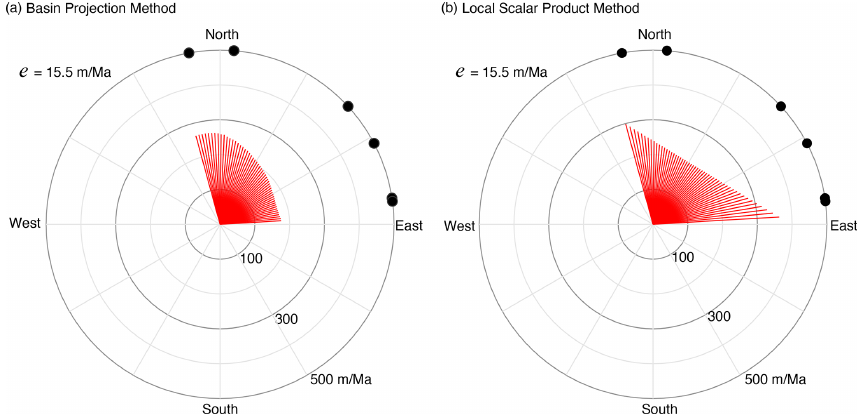
Figure 9. Escarpment retreat rate as a function of azimuth of a horizontal mass flux vector using (a) the basin projection method; (b) the local scalar product method. The basin is from the Western Ghats with location indicated as basin D in Fig. 2. Measured 10 Be concentration is 172426 ( ± 8125)atoms/g and corresponds to a mean vertical erosion rate of 15.5m/Myr. The azimuth of the tangential red lines denotes the assumed escarpment retreat direction, and the length of the radial vector is the consequent retreat rate for that direction and the measured 10 Be concentration. Black dots are orientations of characteristic tributaries of the escarpment-draining channels of this basin.